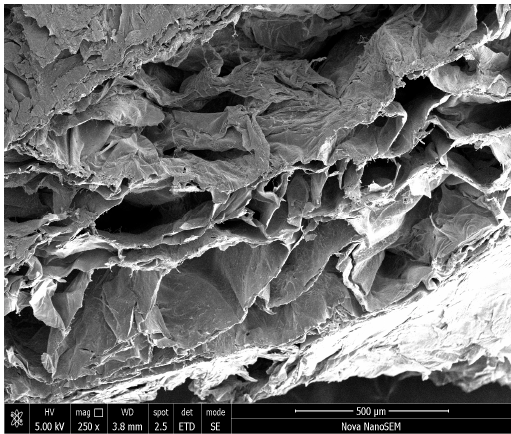
Figure 7. Bulk SEM images at 250× of CH:PVA 3:1 GLU-GLY.